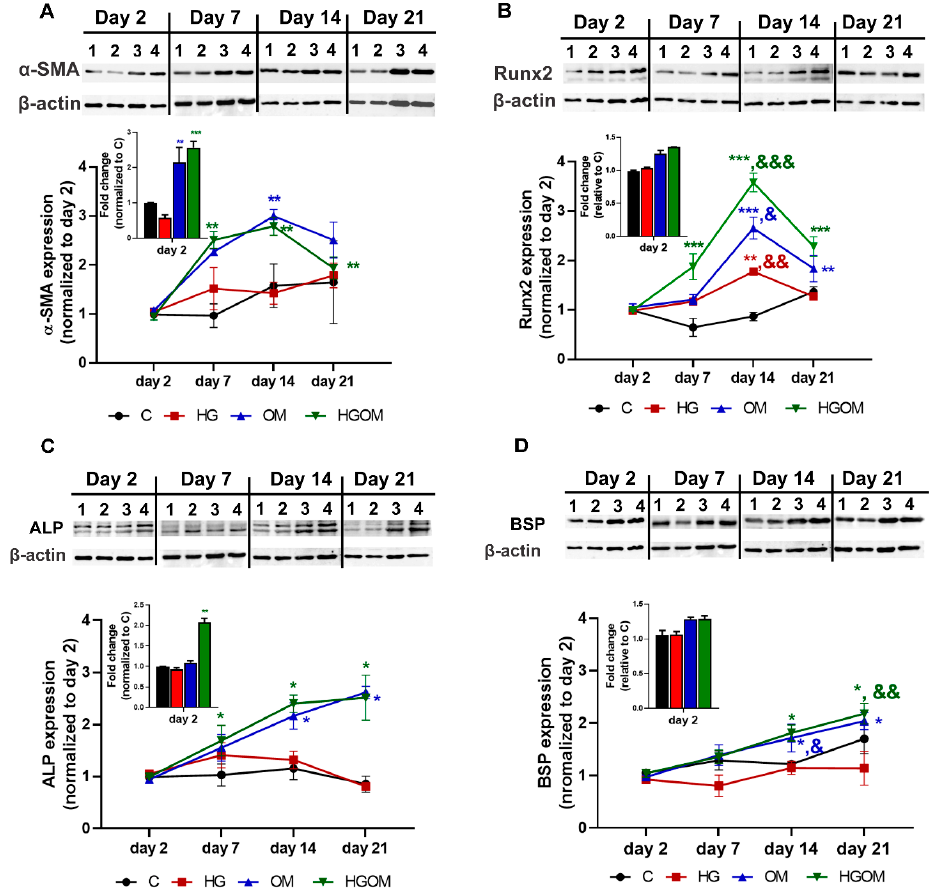
Figure 2. Time course expression of osteogenesis-related markers in valvular interstitial cells (VIC) exposed for 2, 7, 14 and 21 days to C (lane 1), high glucose concentration (HG) (lane 2), osteogenic medium (OM) (lane 3) or a combination of HG and OM (HGOM) (lane 4). The level of protein expression of α -smooth muscle actin ( α -SMA) (A), runt-related transcription factor 2 (Runx2) (B), alkaline phosphatase (ALP) (C) and bone sialoprotein (BSP) (D) was determined by Western blot for different activation conditions, quantified by reporting to β -actin level at different periods and normalized to the day 2 values. Inserts show the level of protein expression at day 2 expressed as fold induction over control cells exposed to 5 mM glucose. Results represent the means ± S.D. of three independent experiments performed in duplicate (n=6). Representative blots are shown above the graphs. *p<0.05, **p<0.01, ***p<0.001 versus values determined at day 2. &p<0.05, &&p<0.01. &&&p<0.001 versus values determined at day 7; Inserts: *p<0.05, **p<0.01, ***p<0.001 versus control.